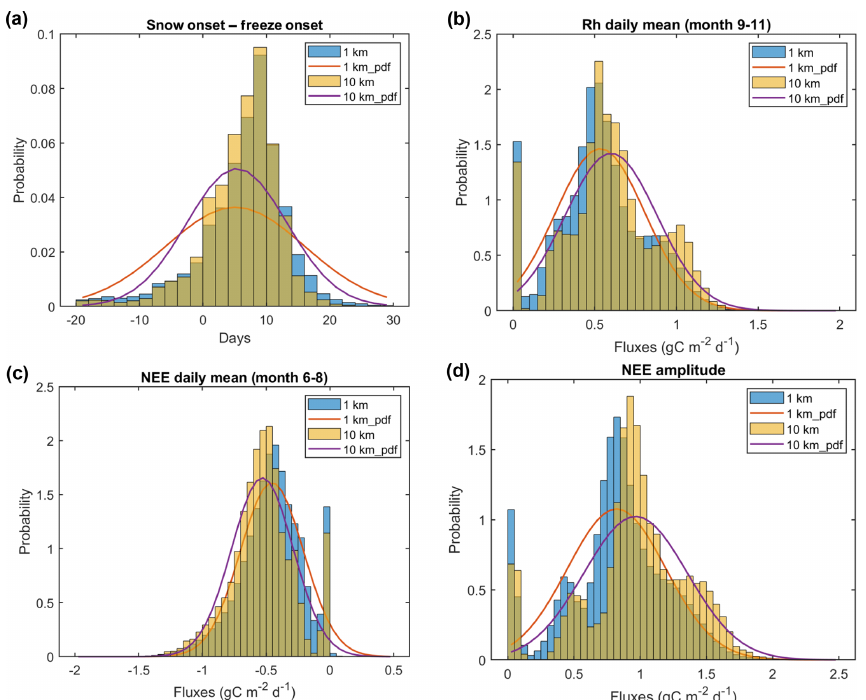
Figure 13. Comparisons of the statistical distribution of model inputs and simulations at the 1 and 10km resolutions across Alaska. (a) The number of snow-free days after land surface freeze onset, derived from the model input LST and snow depth data sets. (b) Model-simulated daily mean Rh flux averaged from September to November. (c) Model-simulated daily mean NEE flux averaged from June to August. (d) Model-simulated NEE amplitude, which was defined as the difference in the daily mean NEE flux between two periods (September– November vs. June–August). The lines show the fitted probability distribution function (pdf) using a normal